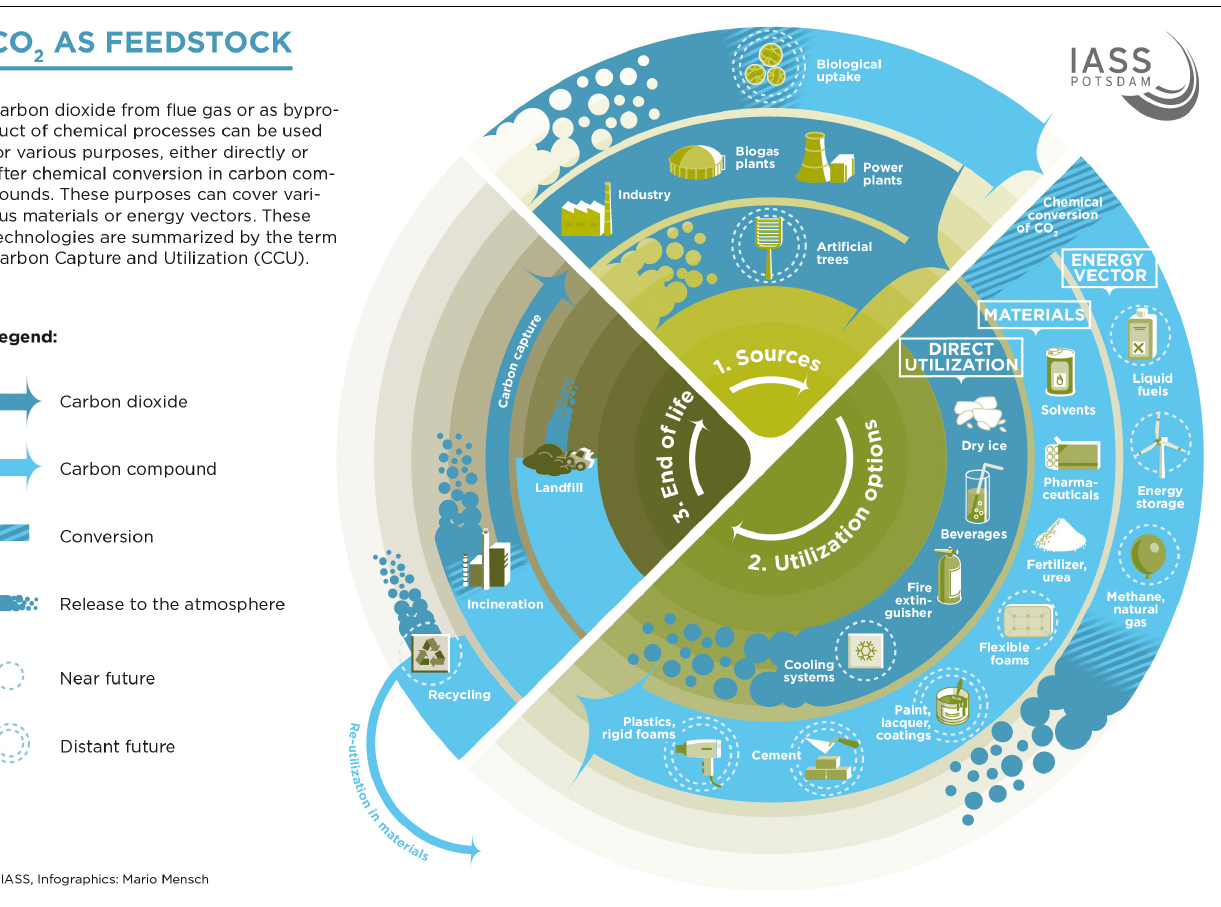
FIGURE 2 | Overview of phases, pathways, and applications of CCU technologies, with focus on cyclic characteristics. Source: IASS/Mario Mensch.